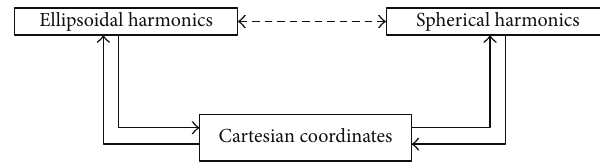
Figure 1: In order to obtain representations of ellipsoidal harmonics intermsofsphericalharmonicsandviceversa,onehastogothrough Cartesian coordinates (solid lines). A direct connection appears not to be feasible (dashed